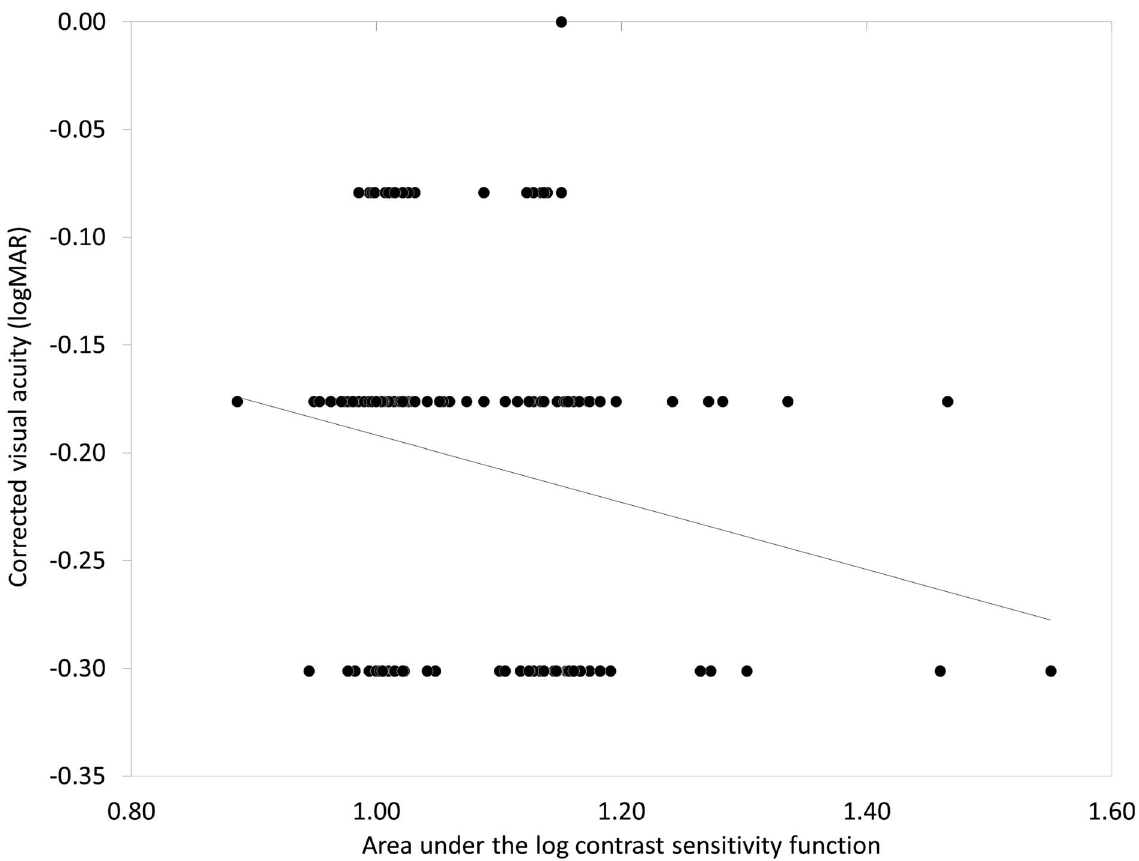
Figure 2. Correlation between the area under log contrast sensitivity function and corrected distance visual acuity.